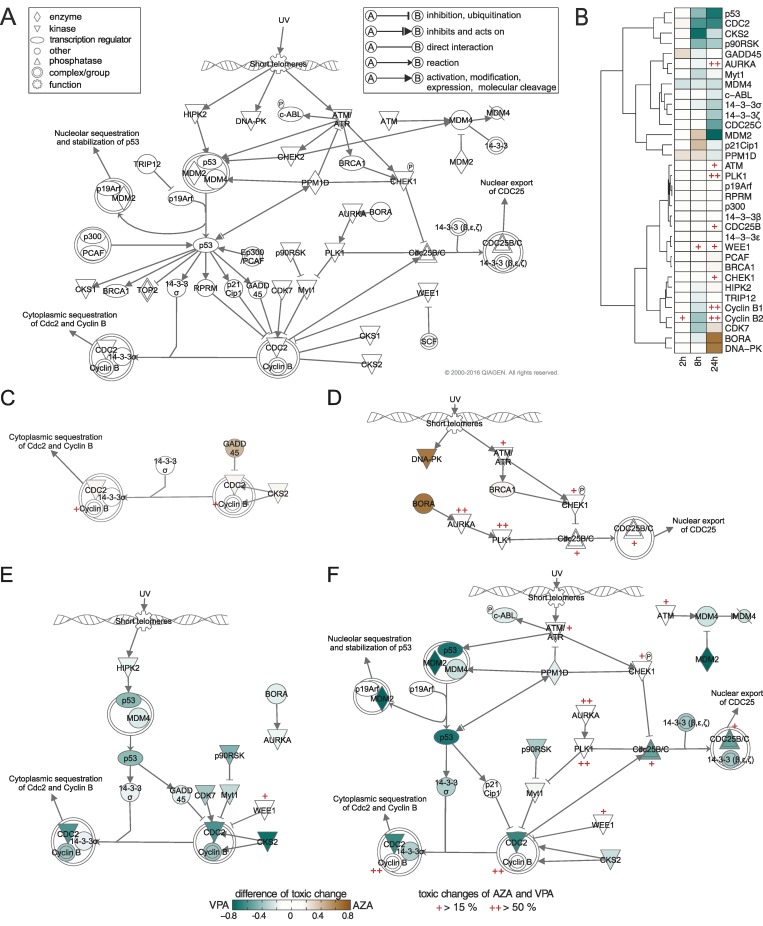
Comparison of toxic changes between AZA and VPA and differential response pathways at different timepoints.The color bar depicts differences of toxic changes between both drugs. Genes with high toxic changes for both drugs were explicitly marked in red.
APathway of ‘cell cycle G2/M DNA damage checkpoint regulation’.BComparison of toxic changes for involved genes between AZA and VPA.CAZA, 2 h.DAZA, 24 h.EVPA, 8 h.FVPA, 24 h.